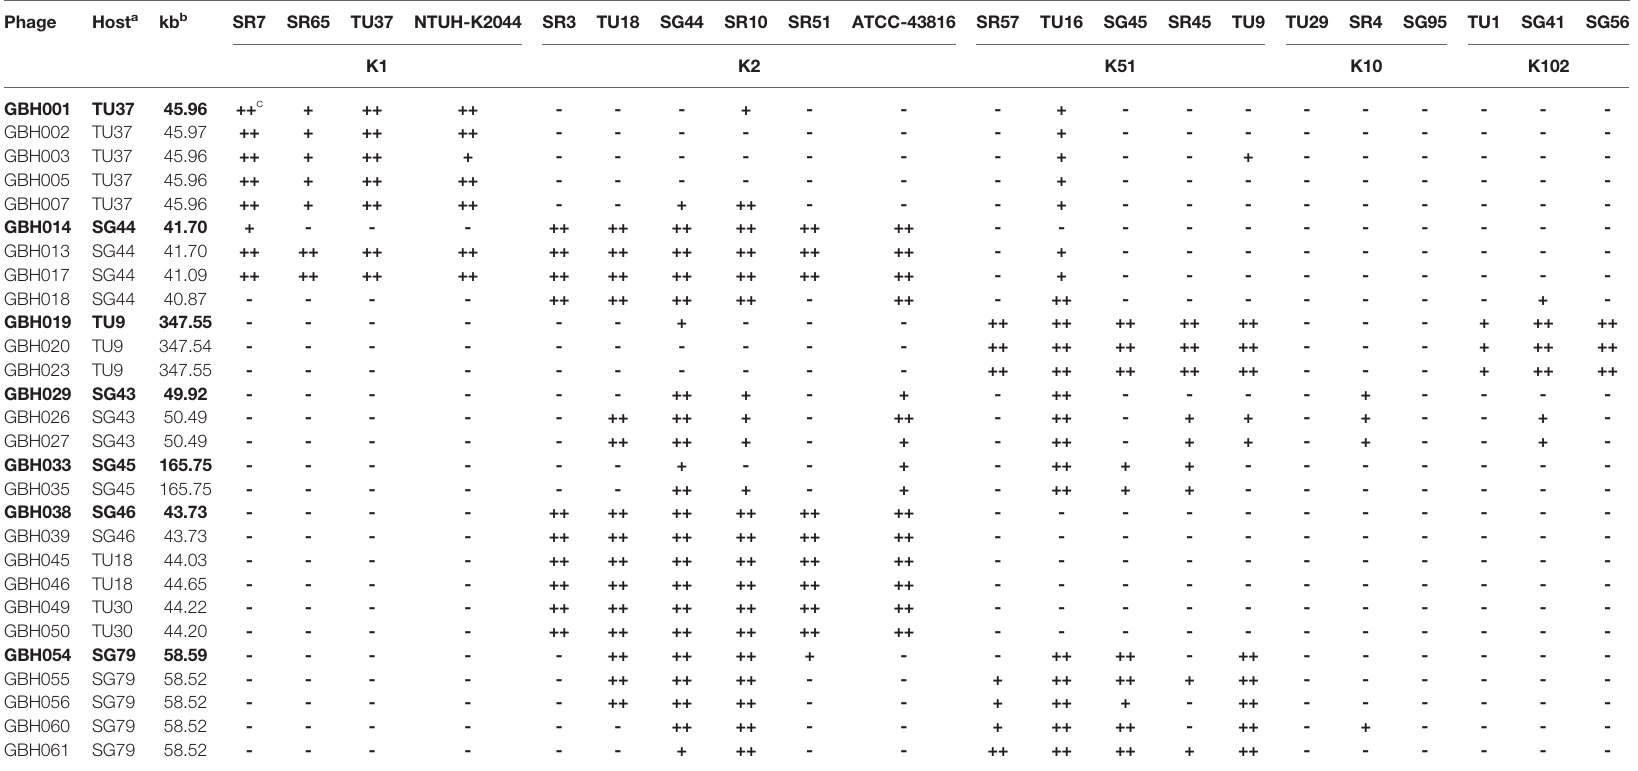
a clinical isolates detailed in Table 1 . b genome length determined from whole-genome data. c clear plaque, ++; +, incomplete lysis; -, no lysis. Determined by spot assay, phage concentration ~10 10 virions/ml. The 28 phages selected fell into seven groups based on sequence similarity of >95%. Exemplars for each group in